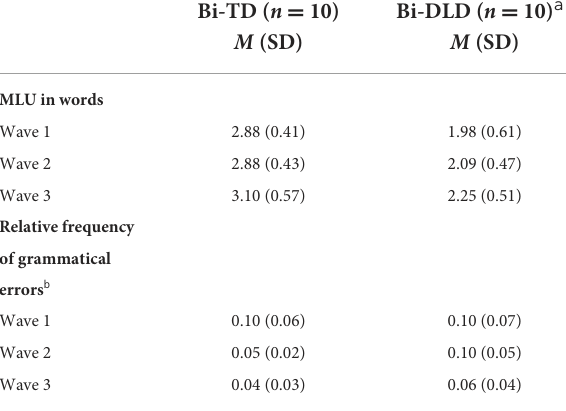
TABLE 3 Mean length of utterance (MLU) and relative frequency of grammatical errors in